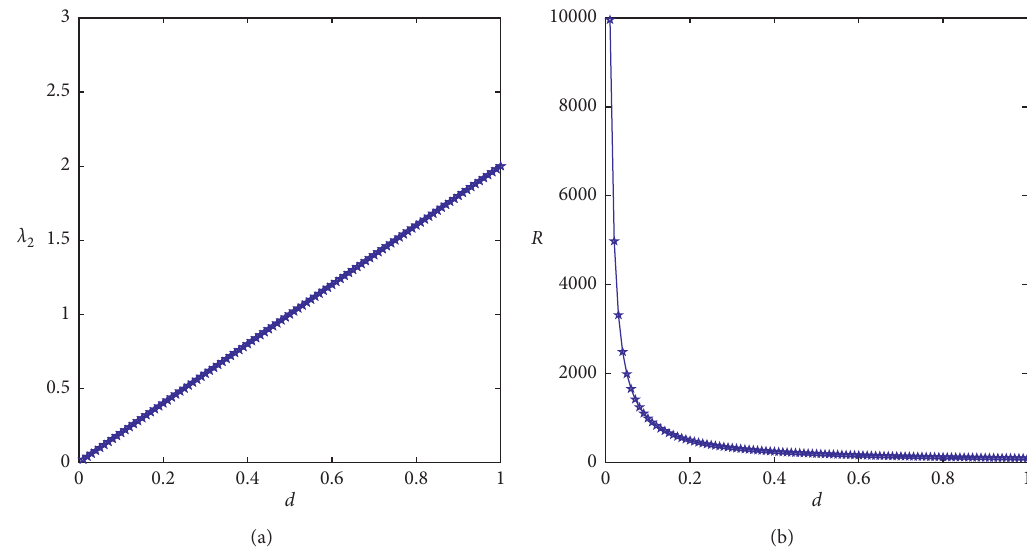
Figure 17: When N is even, the synchronizability of Network II changes with the interlayer coupling strength d between the leaf nodes. (a) λ changes with d ( d changes from 0.01 to 1); (b) R changes with d ( d changes from 0.01 to 1). 2